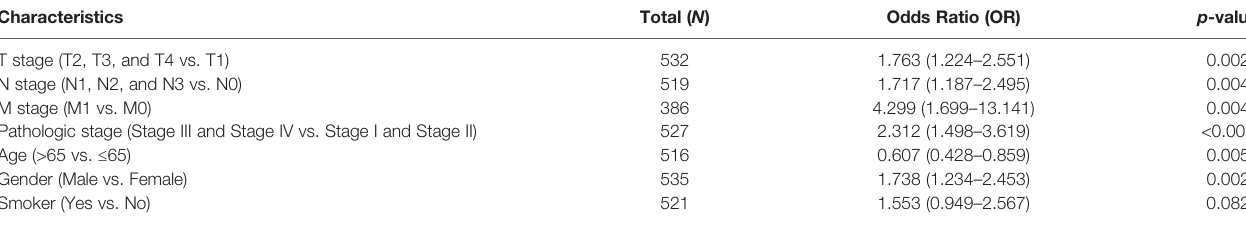
TABLE 2 | Logistic regression analysis of the correlation between NCAPG2 expression and clinical pathological characteristics. Characteristics Total ( N ) Odds Ratio (OR) p -value T stage (T2, T3, and T4 vs.